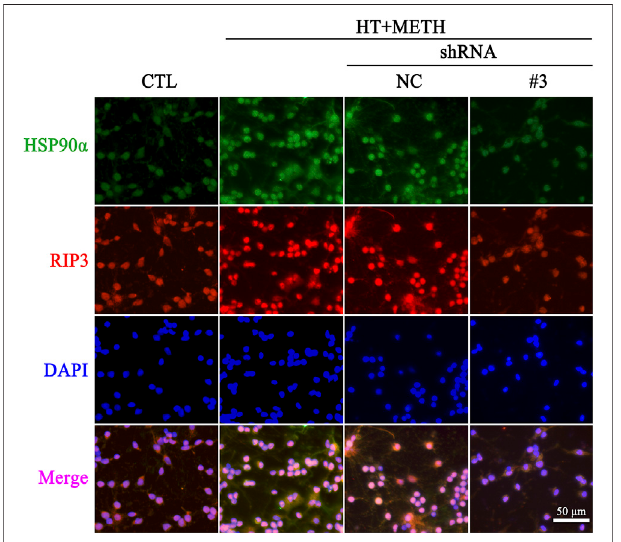
FIGURE 7 | IF of HSP90 α (green) and RIP3 (red) in striatal neurons following METH/HT injury and pre-treatment with HSP90 α shRNA. Scale bar (cid:2) 50 μ m.